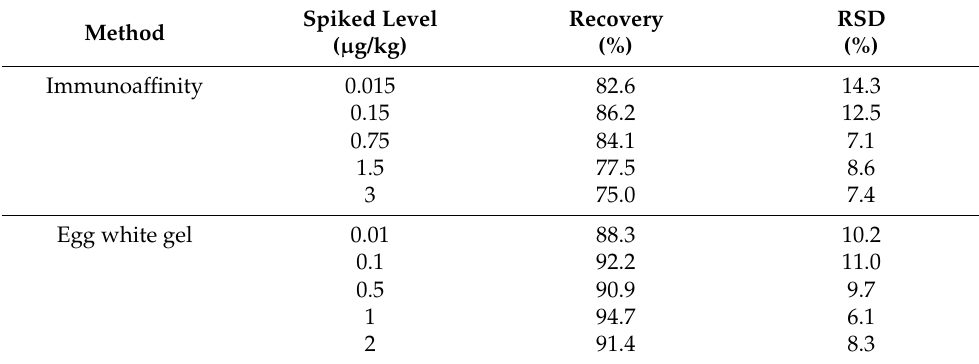
Table 3. Average recovery and precision of AFM1 in milk ( n =